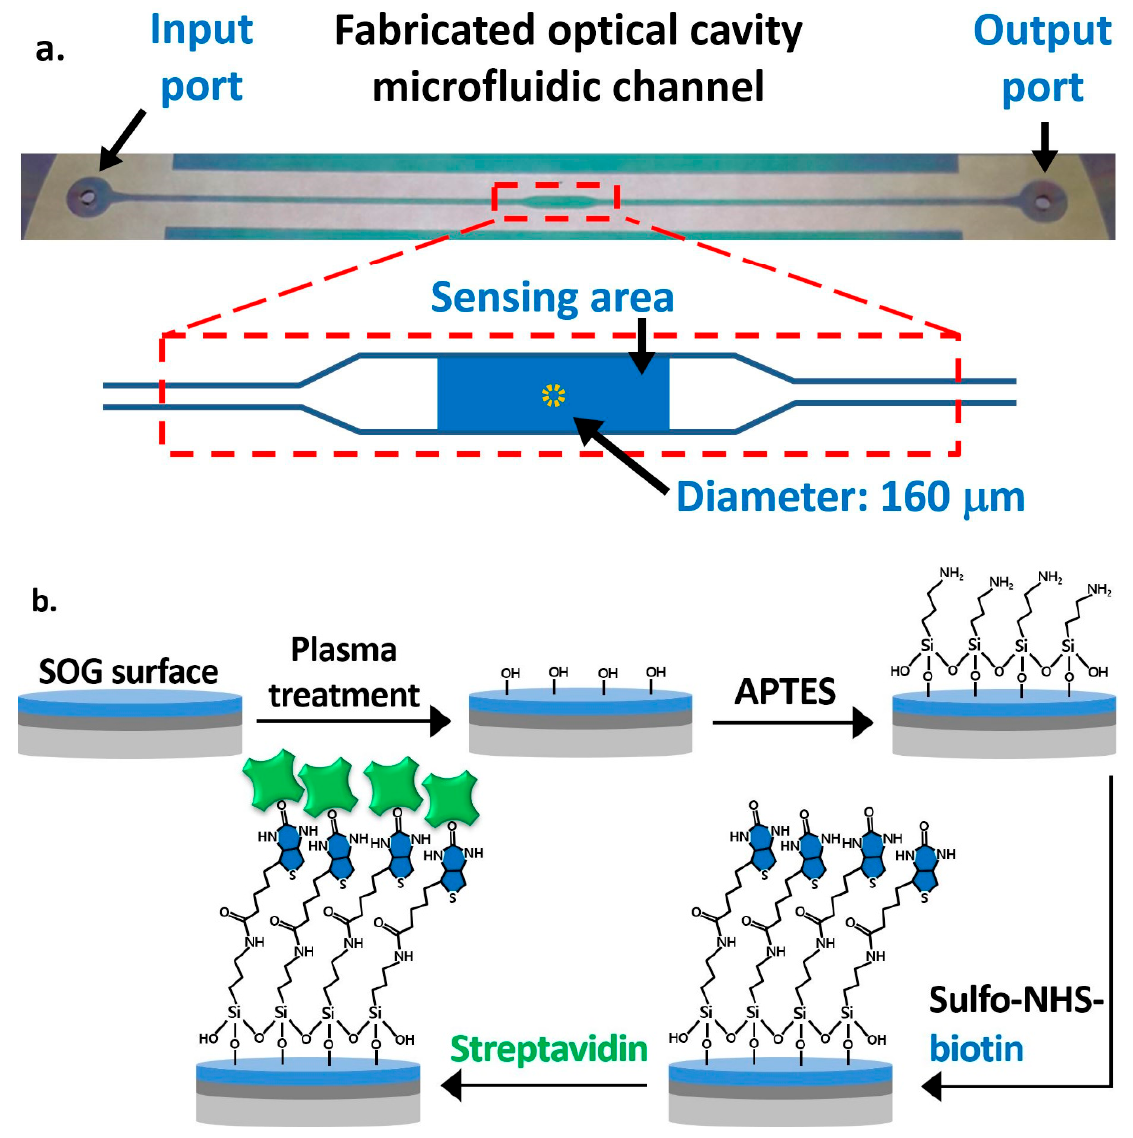
Figure 3. ( a ) Top view of the fabricated optical cavity microfluidic channel indicating the sensing area at the center and the area for the data process. ( b ) The functionalization procedure of the spin-on-glass (SOG) surface for the immobilization of streptavidin.